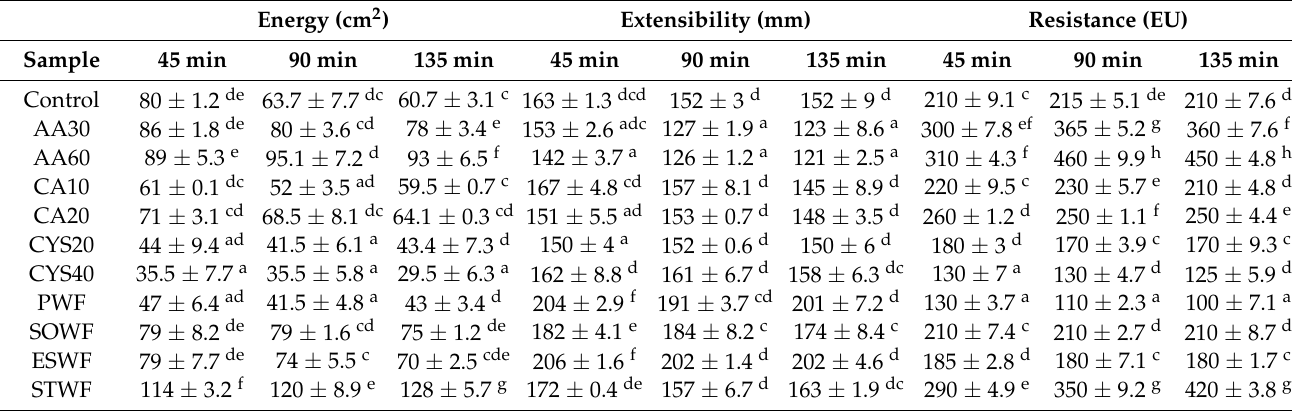
Table 1. Extensograph parameters of flours and control flour with added